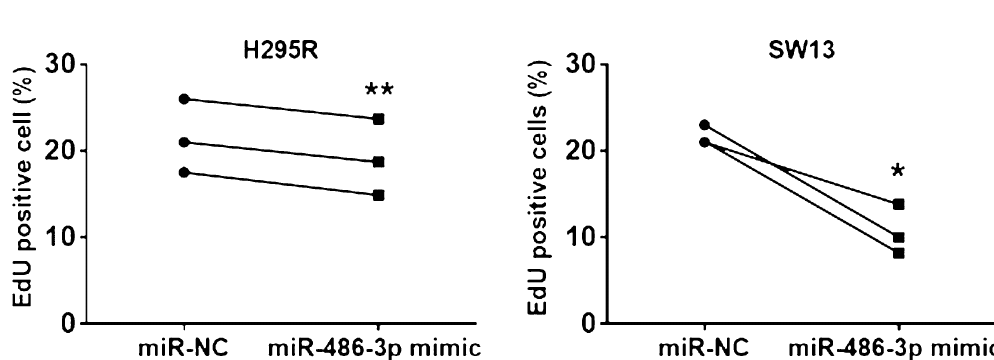
Figure 3. QRT-PCR analysis comparing the expression of miR-486-3p in H295R and SW13 cells, transfected either with miR-486-3p mimic or with scrambled miRNA mimic (miR-NC). The experiments were performed three times.